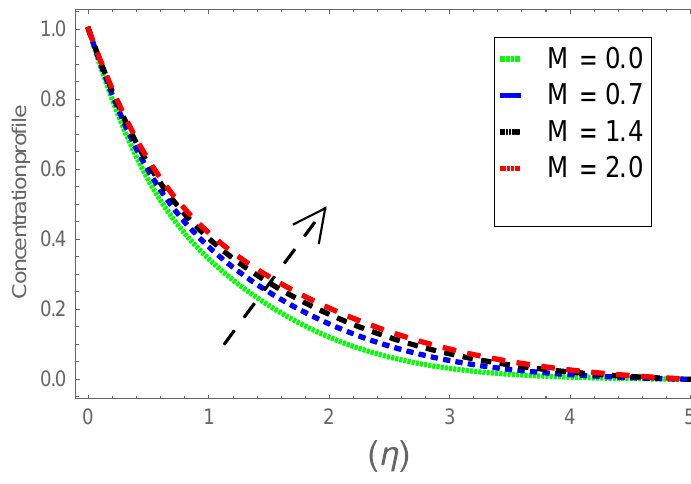
Figure 13. Consequence of ( M ) via θ ( η ) .